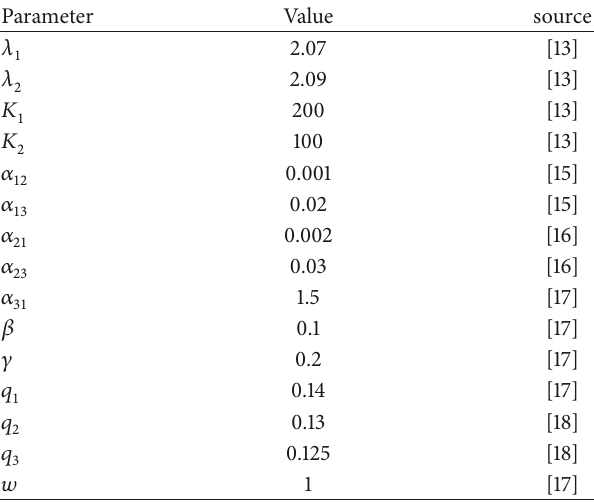
Table 1: Parameter Values of the model.